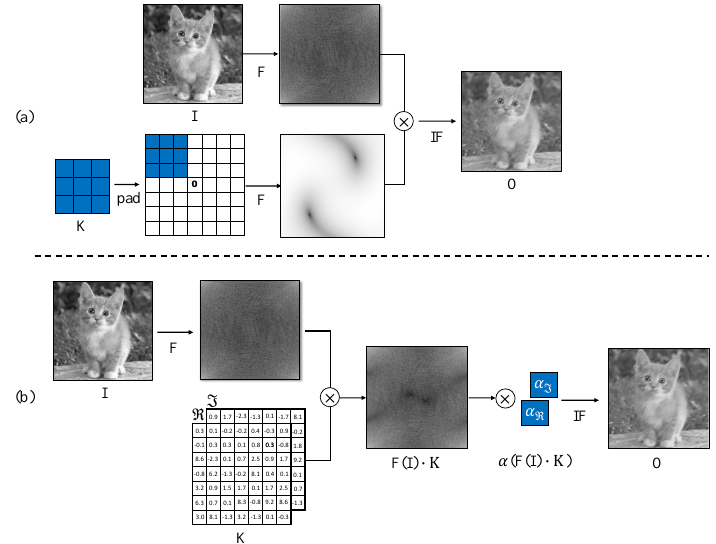
Figure 4. Reconstruction images of our proposed Fourier convolutional layer with a 3 × 3 sized kernel and efficient Fourier convolutional layer based on random kernel. ( a ) Fourier convolutional layer. ( b ) Efficient Fourier convolutional layer. The input gray-scale image denoted as I and K indicates